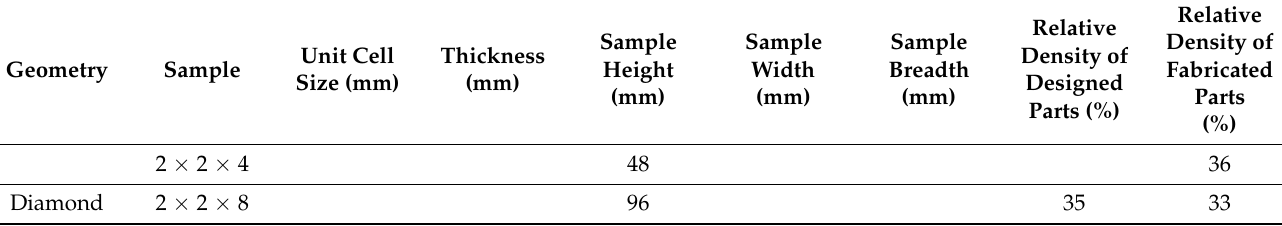
Table 1. The dimension and the design parameter of sample used in this